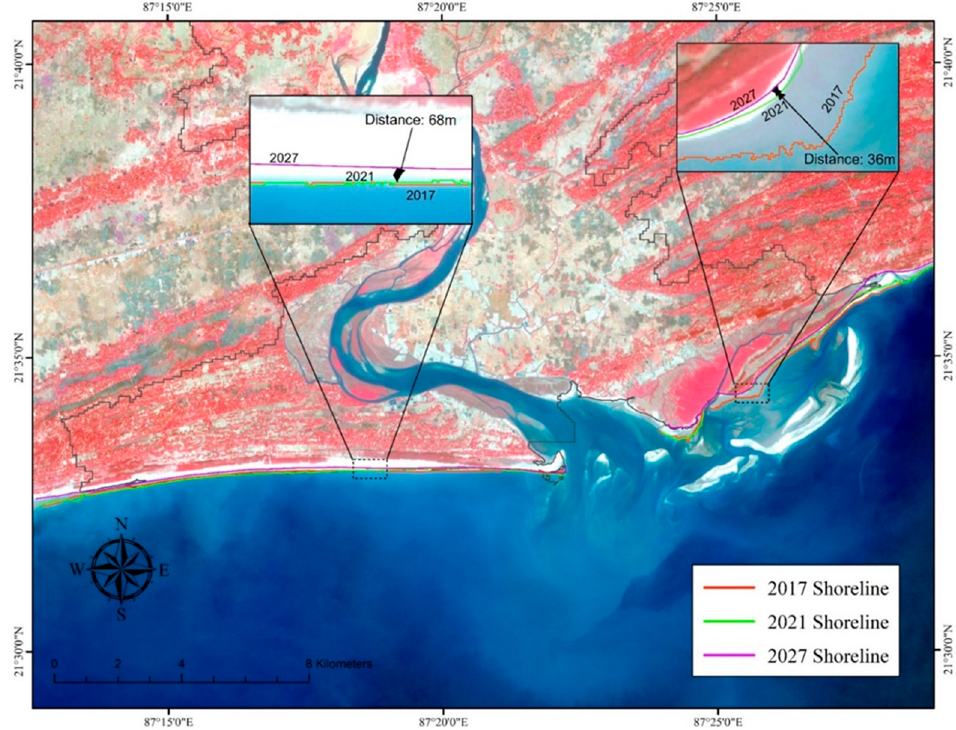
Figure 16. The predicted shoreline position in 2027 of the Subarnarekha’s estuarine section (Digha Coast).